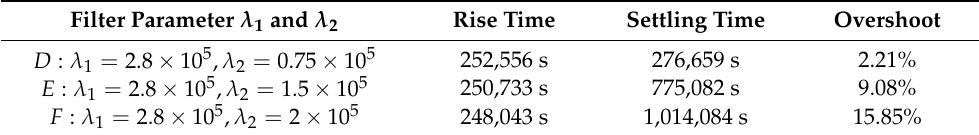
Table 5. Effect of filtering parameter λ 2 on controller disturbance rejection